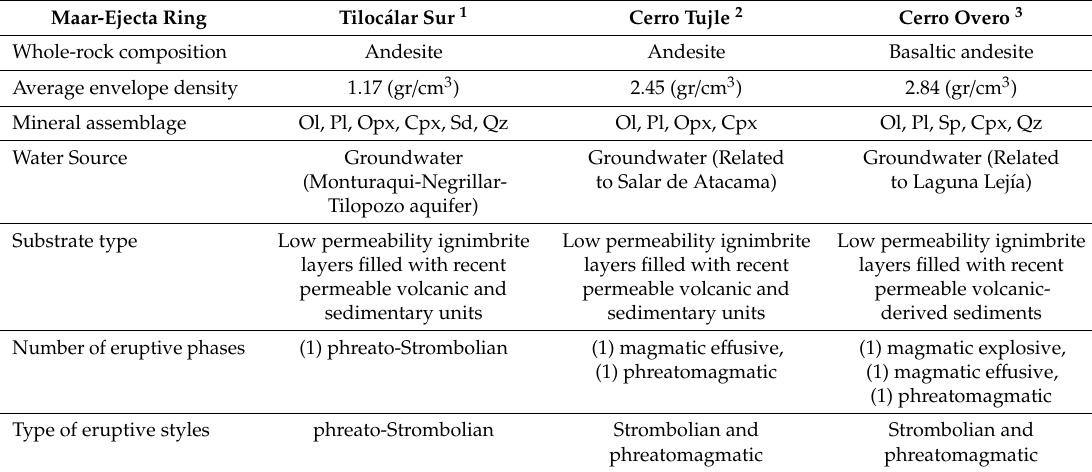
Figure 2. The location map of the Tilocálar Sur, Cerro Tujle, and Cerro Overo maars (red squares) is based on a satellite image acquired from Google Earth TM . The light blue area corresponds to the Monturaqui–Negrillar–Tilopozo (MNT) aquifer boundary, whereas the light green area indicates the Tilopozo wetland, which is considered as the discharge point for the groundwater coming from the MNT aquifer into the Salar de Atacama (modified from [72]). The structural features were taken from Ramírez and Gardeweg [48], Kuhn [73], Aron [74], and González, et al. [75]. Table 1. General features of Tilocálar Sur, Cerro Tujle, and Cerro Overo maars.